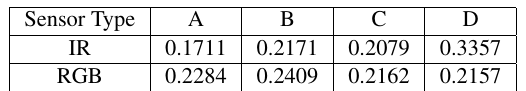
Table 1: Calibration RMS error for IR and RGB sensor (in pixels)